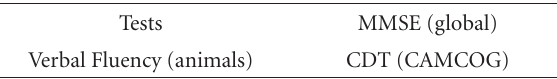
Table 1. Protocol A. Proposal for screening (see text for original references, translations and validations).